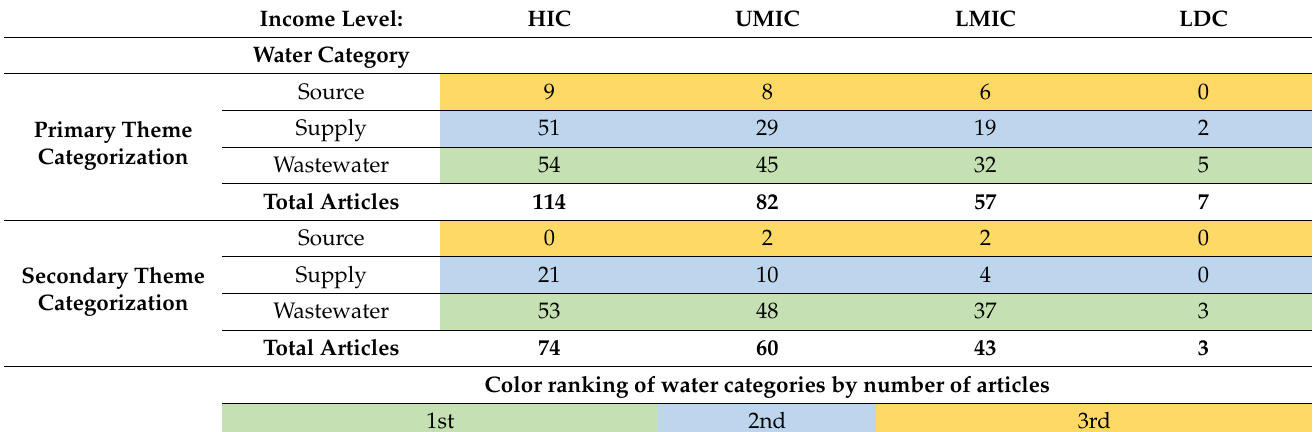
Table 10. Water type distribution ranking of water-related article records by primary and secondary theme categorization of the clean water and sanitation theme in relation to income level ( n =